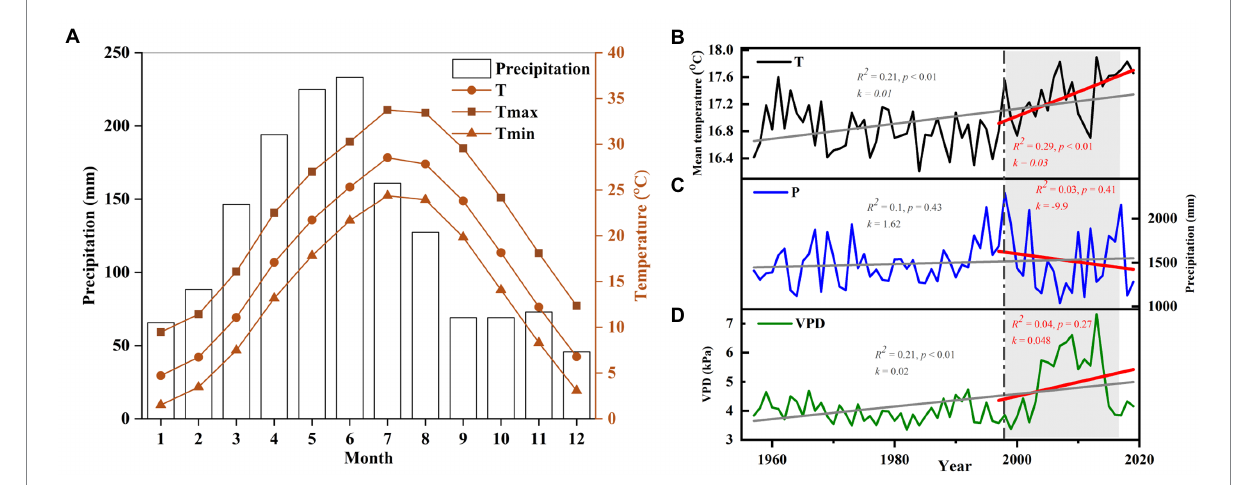
FIGURE 2 (A) Climograph of the study area showing monthly precipitation and temperatures from Pingjiang station during 1958–2019. Change trends of (B) mean temperature (T), (C) annual total precipitation (P), and (D) vapor pressure deficit (VPD). A linear regression equation fitted the interannual precipitation, temperature, and VPD trends from 1958 to 2019 (grey) and 1997 to 2019 (red). The R -squared, the slope ( k ), and the value of p of each model are listed in the figure. Severe drought periods are highlighted with a grey